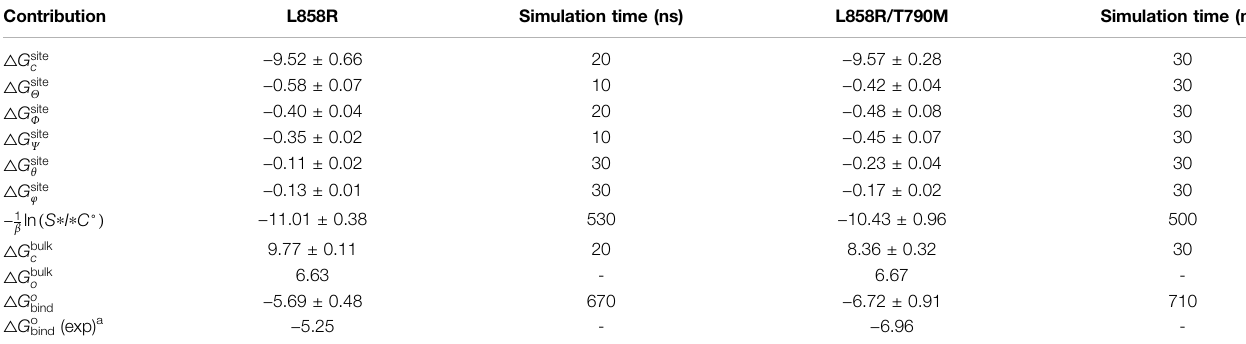
TABLE 1 | Absolute binding free energies (in kcal/mol) for the ligand to EGFR mutants. Contribution